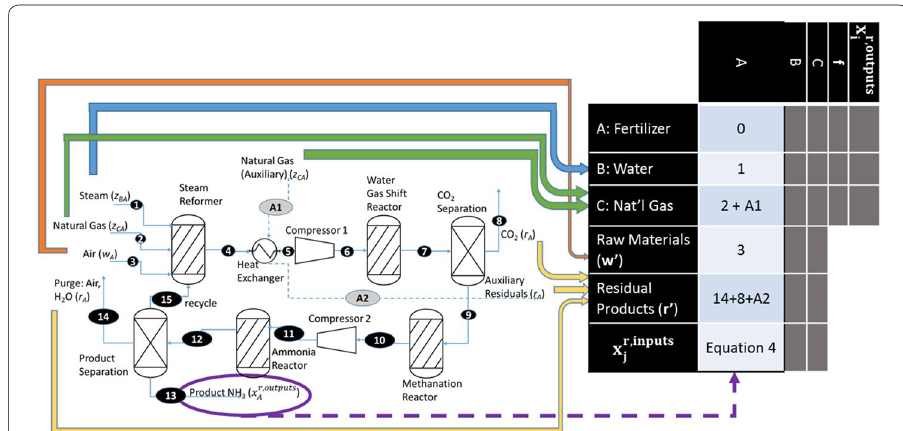
Fig. 3 To the left, a simplified diagram of an ammonia production process model is shown. All primary flow streams are labeled in black circles. Auxiliary streams are numbered in gray circles. Streams are mapped to the PIOT framework at right, following the arrows. Stream numbers included in the categories are shown in the PIOT. This is an example of a single sector A, outputs of other sectors in this sample economy are shaded. As referred to in the text, the process information fills the column for the given sector. The IO identity that x r ,outputs x r ,inputs A = A is used to fill the total output